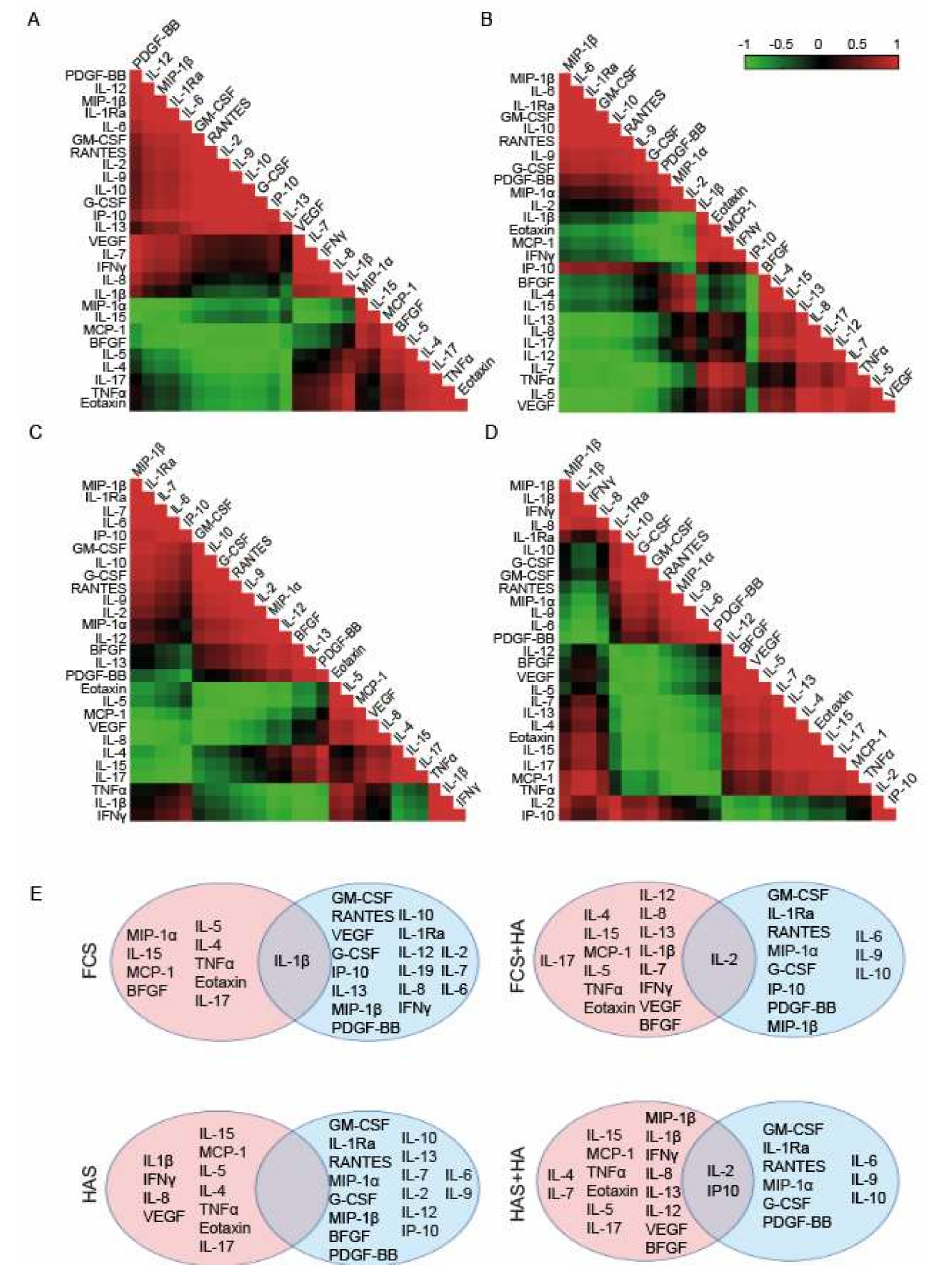
Figure 5. Correlations of cytokines and growth factor changes visualized as heatmaps for all condi- tions: ( A ) FCS, ( B ) FCS + HA, ( C ) HAS and ( D ) HAS + HA. Red color represents values close to 1 of the Pearson’s correlation, suggesting positive correlation patterns. Green color represents values for the Pearson’s correlation close to − 1, indicating negative correlations. Black color means no direct correlation between the genes. ( E ) Scheme of genes manually separated according to their correlations into two blocks that negatively correlate between them. There is no color code meaning. (N = 3). Abbreviations: fetal calf serum (FCS), hyperacute serum (HAS), hyaluronic acid (HA), interleukins (IL-), tumor necrosis factor alpha (TNF α ), interferon gamma (IFN γ ), interleukin 1 receptor antago- nist (IL-1Ra), monocyte chemotactic protein 1 (MCP-1), 10 KDa interferon gamma-induced protein (IP-10), macrophage inflammatory proteins (MIP), regulated upon activation normally T-expressed and presumably secreted (RANTES), granulocyte macrophage colony stimulating factor (GM-CSF), granulocyte colony stimulating factor (G-CSF), vascular endothelial growth factor (VEGF), basic fibroblast growth factor (BFGF) and platelet-derived growth factor subunit B